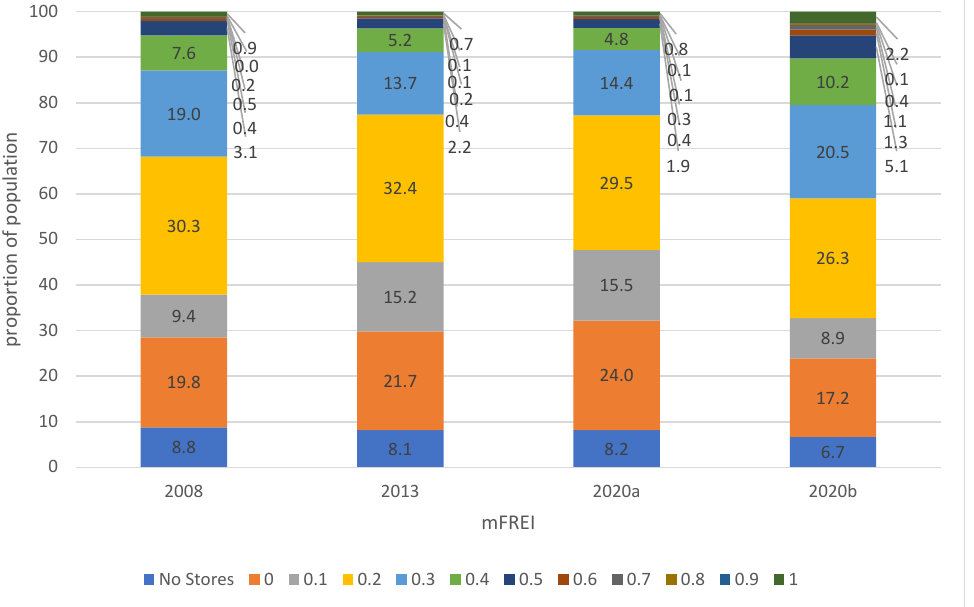
Figure 6. The evolution of food swamps in residential areas between 2008 and 2020, expressed on a population basis. The proportions are based on the total number of people living in the residential areas. 2008, 2013 and 2020a are the food swamp scores based on Locatus data only. 2020b are the food swamp scores based on the Locatus data and the extra dataset of community gardens, farmers’ markets and farmers’